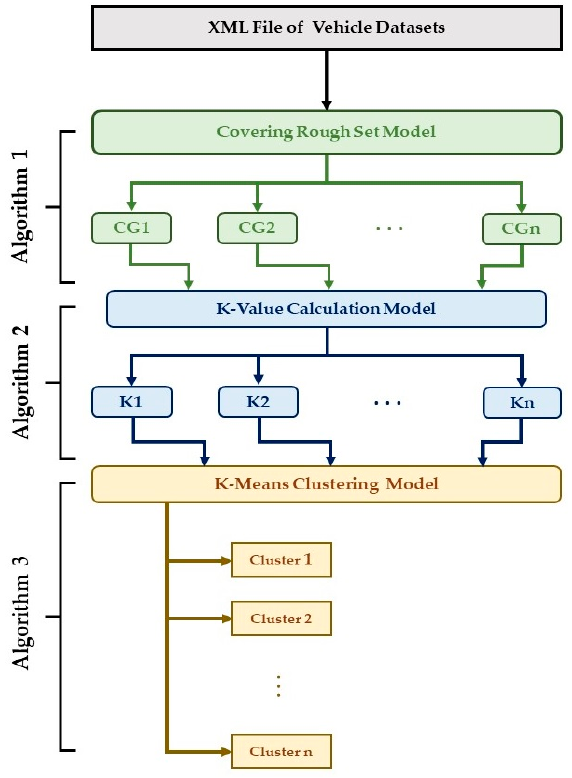
Figure 2. Proposed clustering stages.